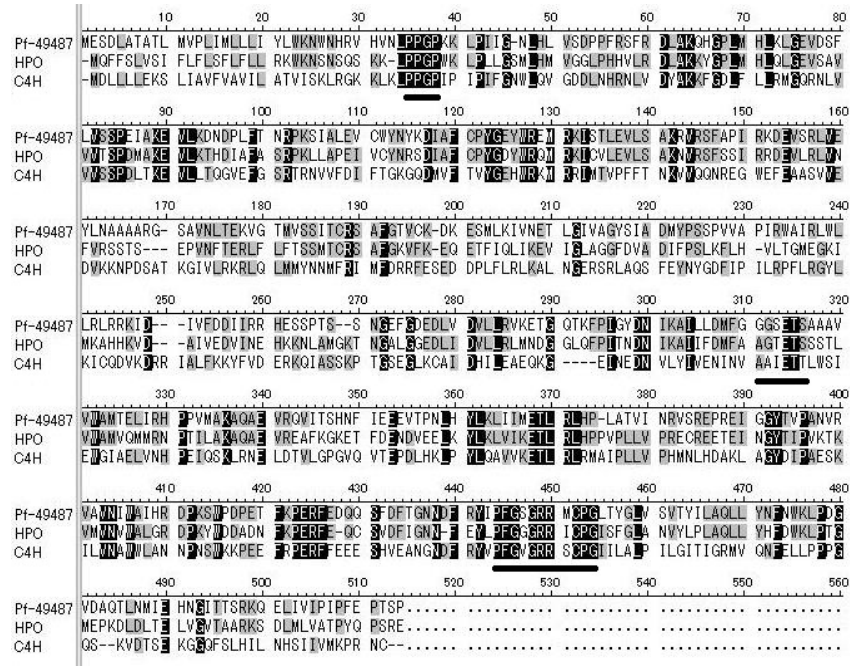
Figure 3. Alignment of the amino acid sequences of Pf-49487 . HPO: Hyoscyamus muticus premnaspirodiene oxygenase (GenBank Accession No. EF569601), C4H: cinnamate 4-hydroxylase (Arabidopsis thaliana) (GenBank Accession No. NP180607). The following conserved regions of P450 are underlined: the proline-rich region, the oxygen-binding pocket, and the heme-binding region from upstream of the sequence. Black background indicates 100% amino acid identity among the three clones and gray background indicates greater than 50% amino acid